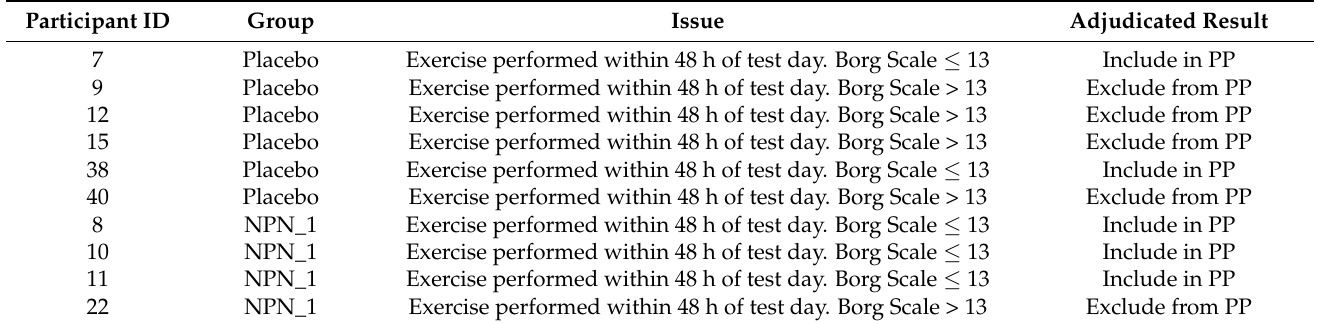
Table 2. Population allocation adjudication results based on exclusion criteria.